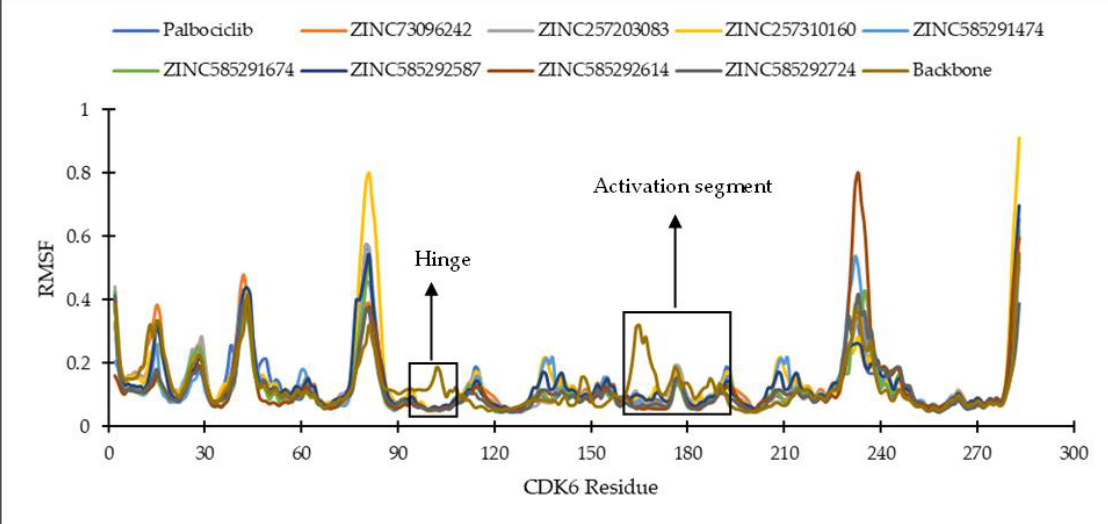
Figure 7. The RMSF of the amino acid residue of CDK6 during the MD